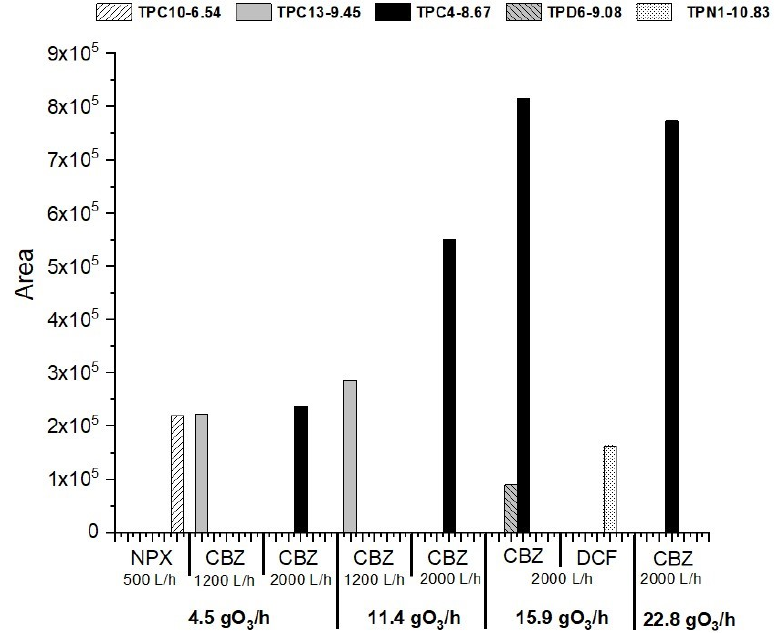
Figure 5. TPs obtained according to the selected suspect list under different operational condi-